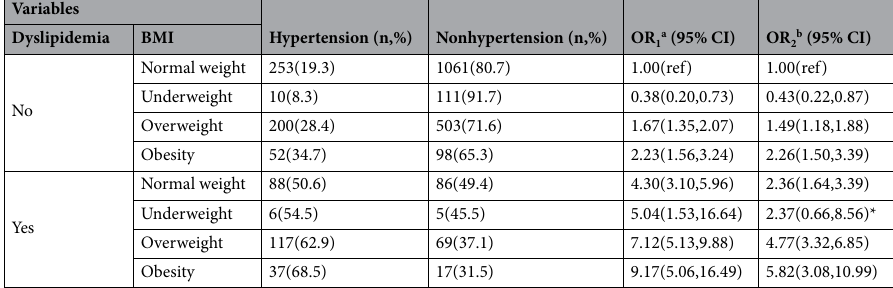
Table 3. The interaction between BMI and dyslipidemia on the risk of hypertension. a OR 1 is the result of univariate analysis. b OR 2 is the result of multivariate analysis. The adjusted confounding factors included sex, age, diabetes, education level and occupation. *Not statistically significant.